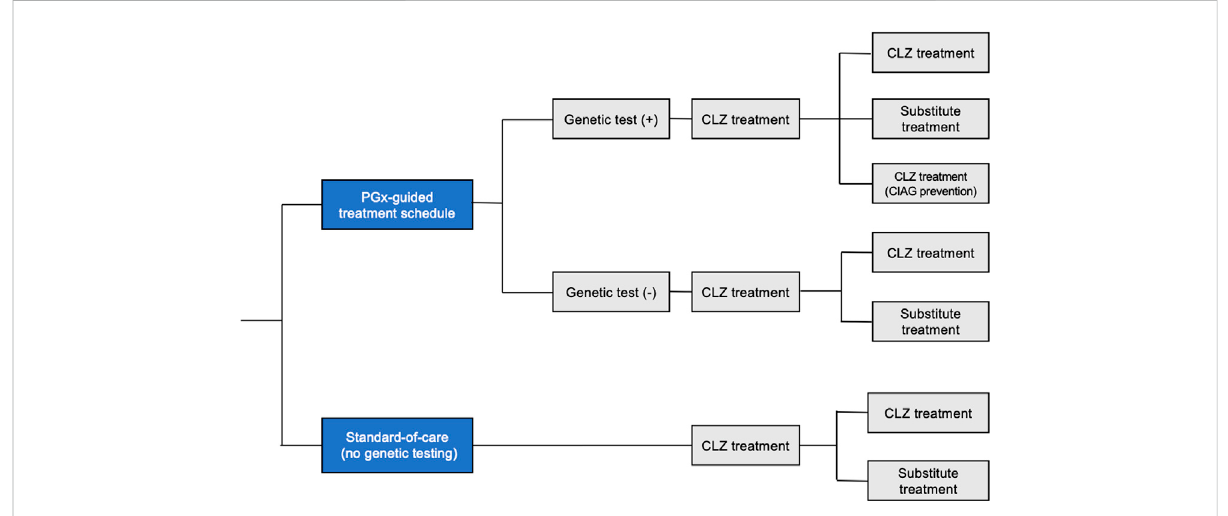
FIGURE 1 Decision tree schematic. The “ Standard-of-care (no genetic testing) ” compared with the “ PGx-guided treatment schedule. ” CIAG, clozapine- induced